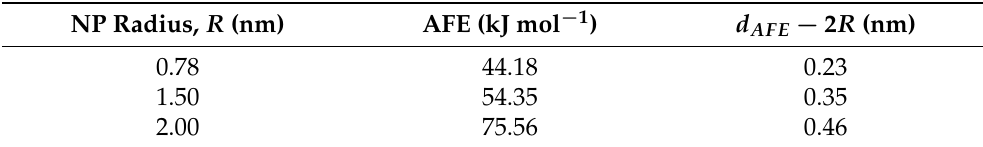
Table 2. Aggregation free energy (AFE) and its distance from the surface d AFE − 2 R of NPs pairs in water, calculated using Classical MD and US technique; the aggregation free energy was evaluated as the depth of the potential well (see Figure 2).